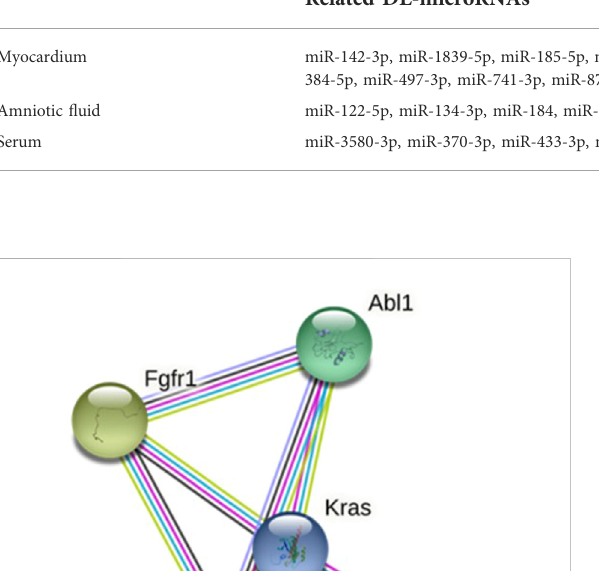
TABLE 2 DE-microRNAs related to hub genes.